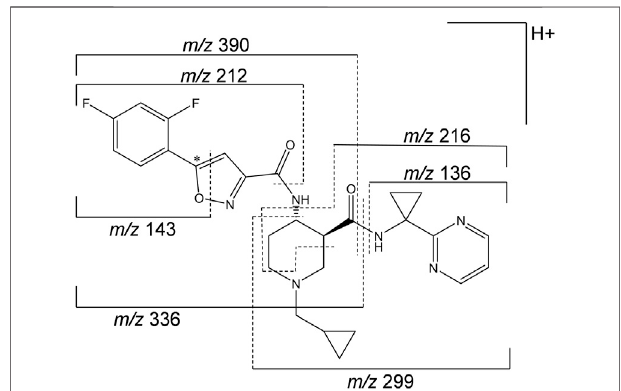
FIGURE 6 | Mass spectrometric fragmentation pattern of 14 C-ACT- 1004-1239. The asterisk (*) indicates the position of the 14 C label, which was taken into consideration for the applicable accurate fragment masses ( m/z ). The fragment ion with m/z 212 includes in addition to the depicted pattern two hydrogen